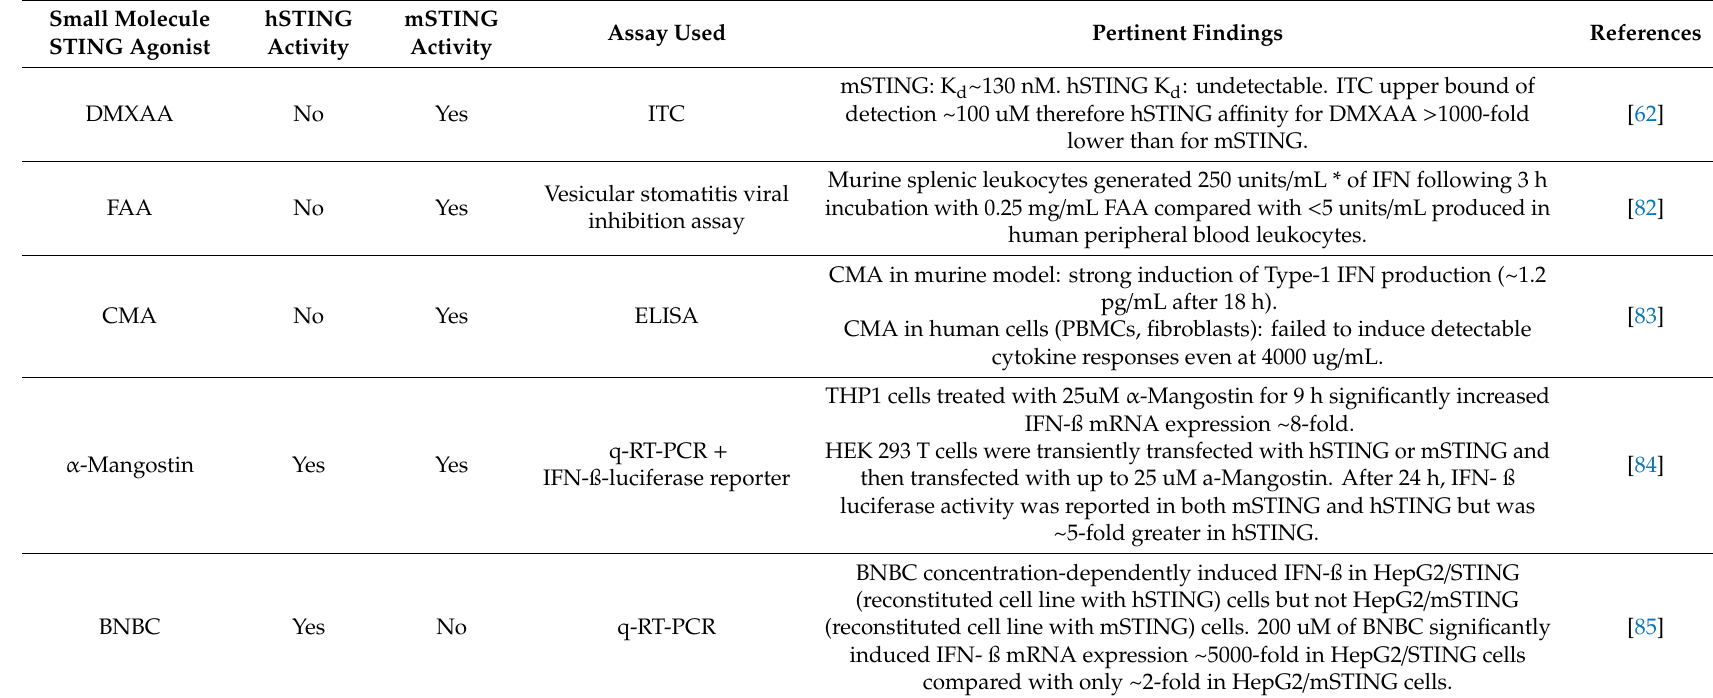
Table 1. Non-nucleotidyl small molecule stimulator of interferon genes (STING) agonists and their inhibitory activities at mouse and human STING. Small